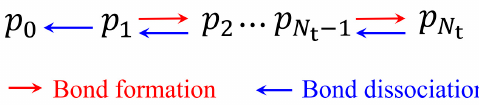
Figure 3. Kinetic network describing the evolution of the number of closed bonds.